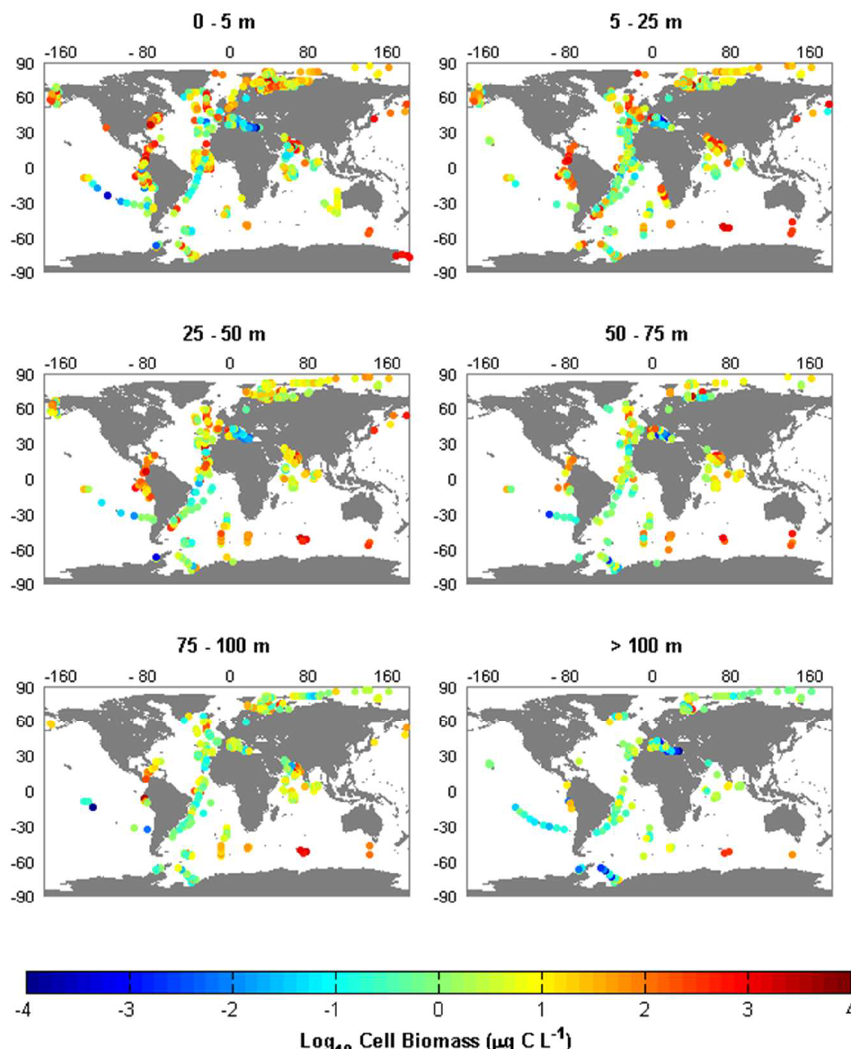
Figure 4. Mean log-normalized diatom biomass (log 10 µ gCl − 1 ) for di ff erent depth layers.